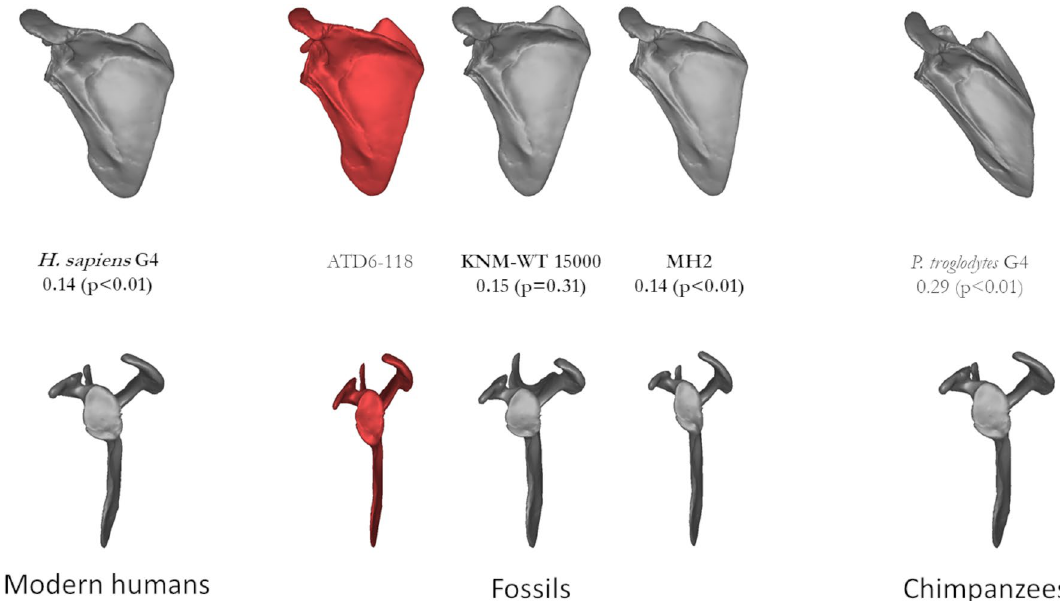
Figure 3. Mean shape comparisons from ATD6-118 (left center, red) next to the most similar groups based on size and (probable) developmental stage. The Procrustes distance from ATD6 to each group is shown as well as the result of the permutation test.